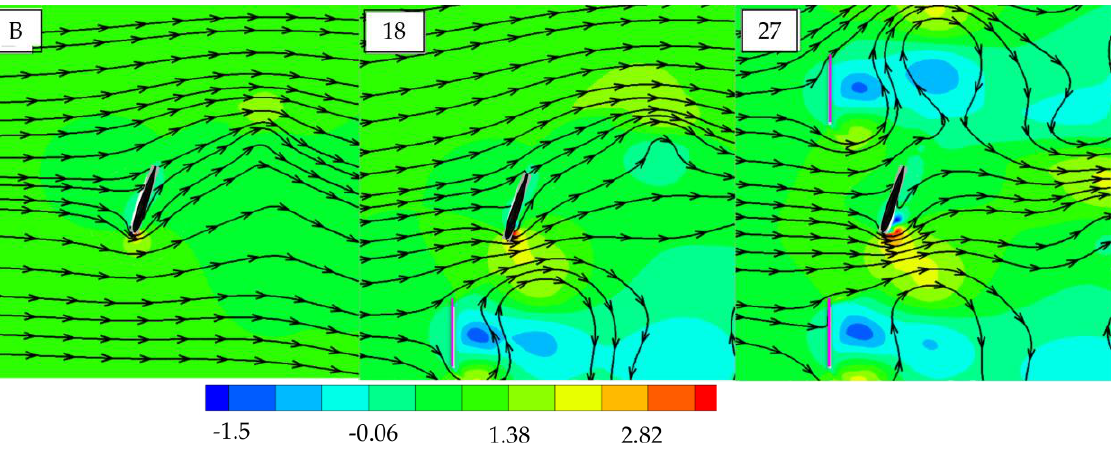
Figure 11. A comparison of the streamwise velocity and streamlines of an oscillating hydrofoil equipped with a single/dual upstream deflector.